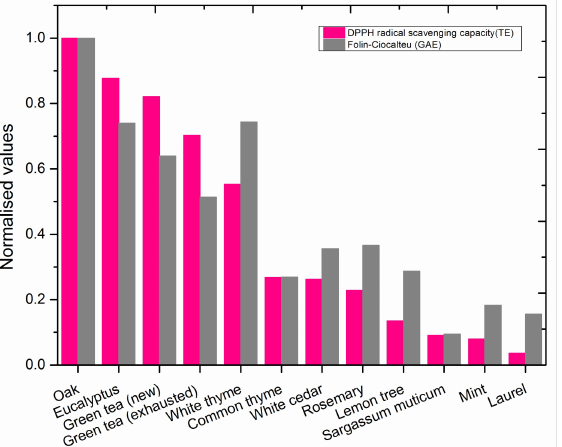
Figure 1. Determination of total antioxidant capacity of plant extracts with traditional methods: Folin–Ciocalteu and DPPH radical scavenging capacity. Normalized values respect the maximum value of each